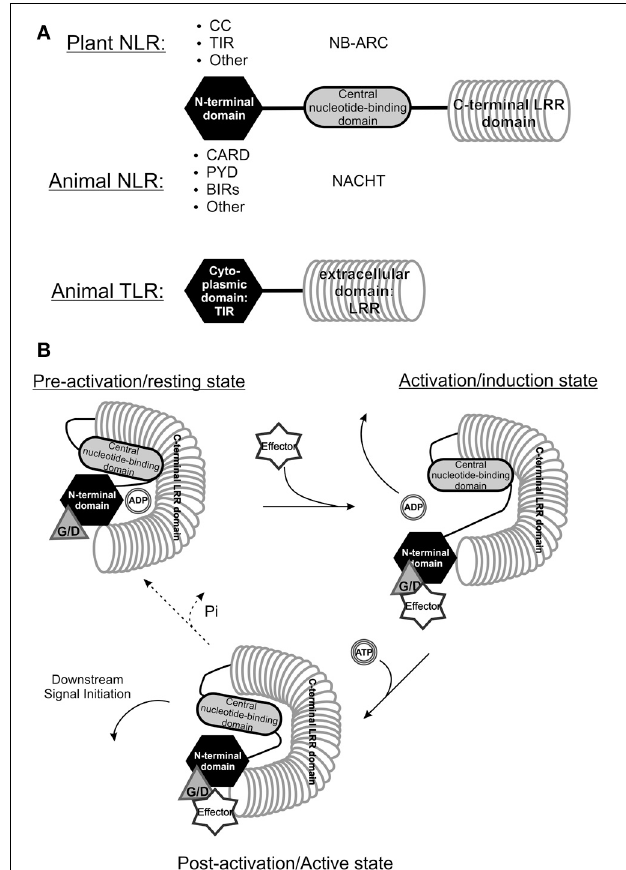
FIGURE 2 | Comparison between the structure of plant and animal NLRs. (A) The structure of “Nucleotide binding and leucine rich repeat proteins” (NLRs) from the animal and plant kingdom share highest homology, as all proteins belonging to this class have a C-terminal leucine rich repeat (LRR), a central nucleotide binding domain and a varying N-terminal domain (modified from Maekawa et al., 2011b). Animal TLRs also contain an (extracellular) LRR domain and possess a TIR-domain, they do however, lack a nucleotide binding domain. CC, Coiled-coil; TIR, Toll-interleukin receptor; CARD, Caspase-activation and recruitment domain; PYR, Pyrin domain; BIR, Baculovirus inhibitor-of-apoptosis repeats; NB-ARC, Nucleotide binding and Apaf1-R protein-CED4 domain; NACHT, NA IP – CIITA - HET-E - TP1 domain. (B) A model of NB-LRR R protein recognizing a specific Avr protein through a guardee or decoy host protein. Upon interaction with the Avr protein the R protein conformationally changes and the ADP can be exchanged for ATP, leading to a second conformational change triggering downstream resistance (Modified from Lukasik and Takken, 2009). Whether the R protein returns to its resting state is not known yet. G/D,